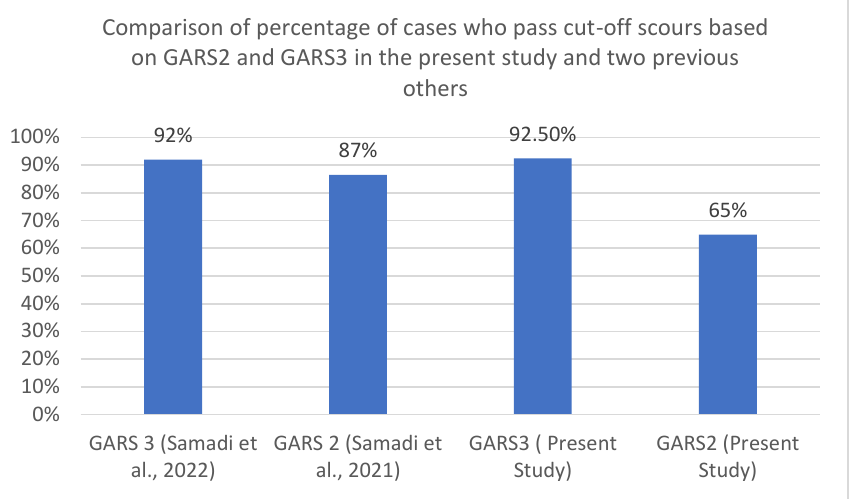
Figure 2. Comparison of the groups who passed the cut-off scours of GARS-2 and GARS-3 in the present study and two previous others.